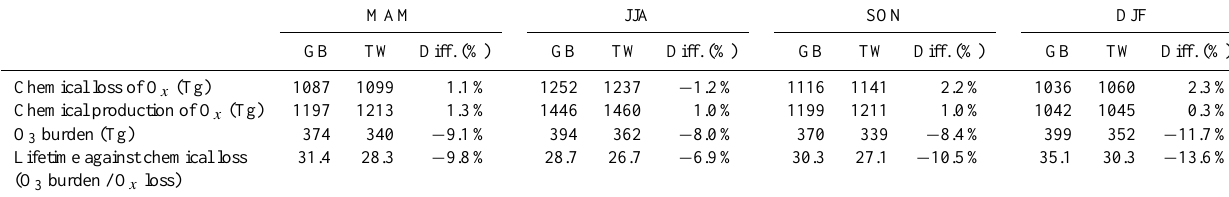
Table 4. Global tropospheric ozone burden and O x chemical production and loss in individual seasons of